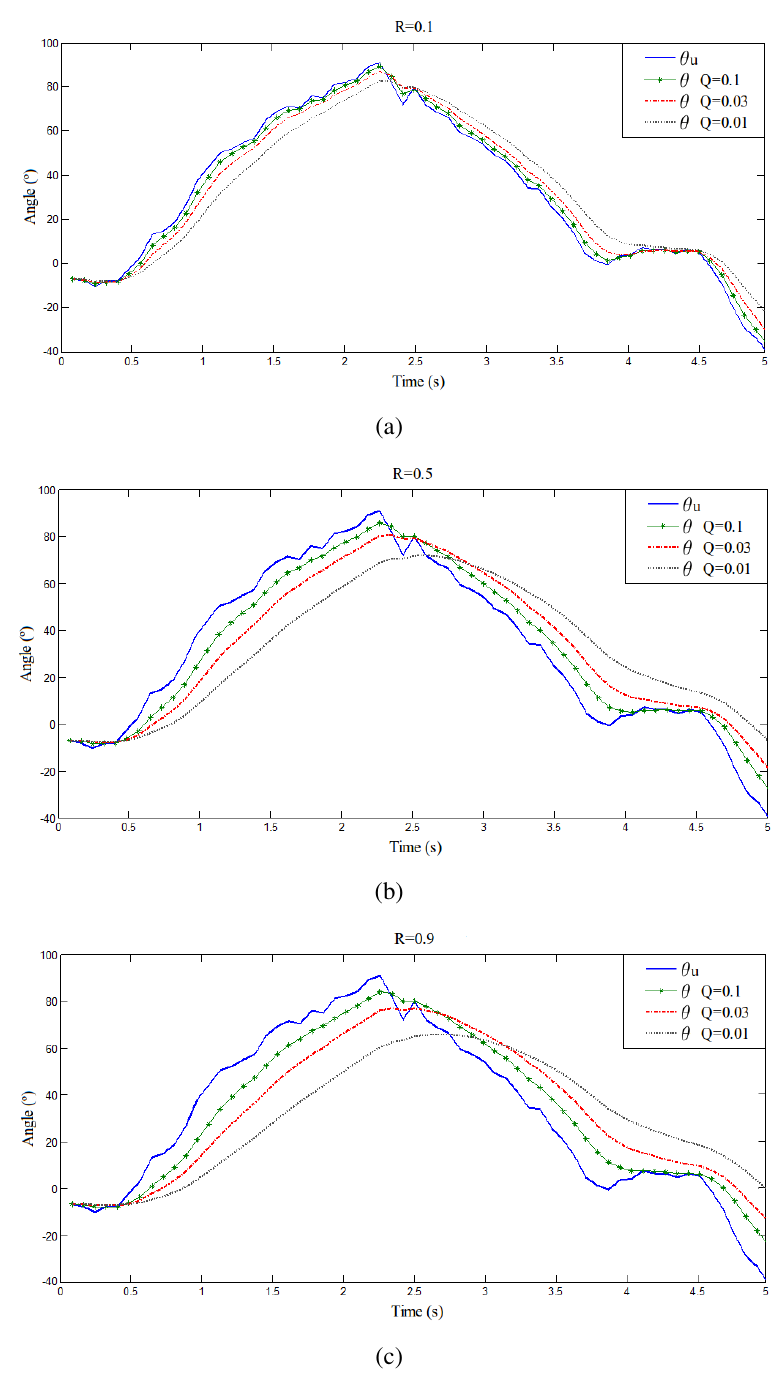
Figure 5. Comparative study of Kalman filter response for Q and R